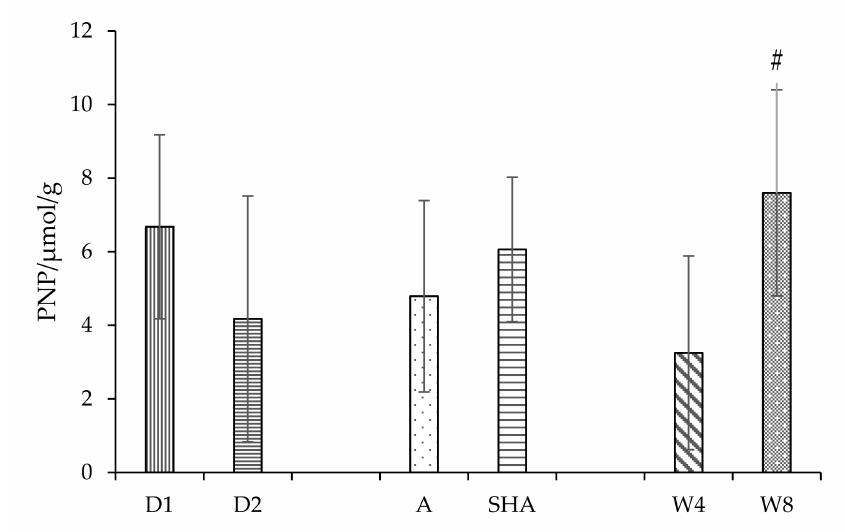
Figure 6. Summary of GlA enzyme activity results by treatments (doses), soil types, and sampling weeks. The codes are as follows: D1: Dose 1. D2: Dose 2. A: Arenosol. SHA: slightly humous Arenosol. W4: Week 4. W8: Week 8. # indicates significant difference at p < 0.05 (calculated by Duncan-test) between W4 and W8.